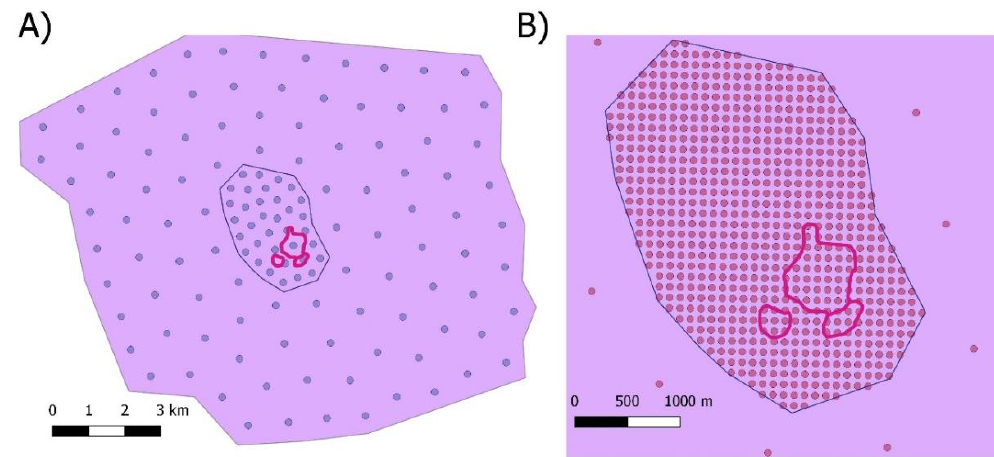
Figure 4. Pilot point locations for the IES calibration. ( A ) Regional study area (RSA) and local study area (LSA) pilot point locations for recharge, storage and hydraulic conductivity multiplier field parameters; ( B ) LSA pilot point locations for geostatistical simulations of fresh rock horizontal hydraulic conductivity fields.